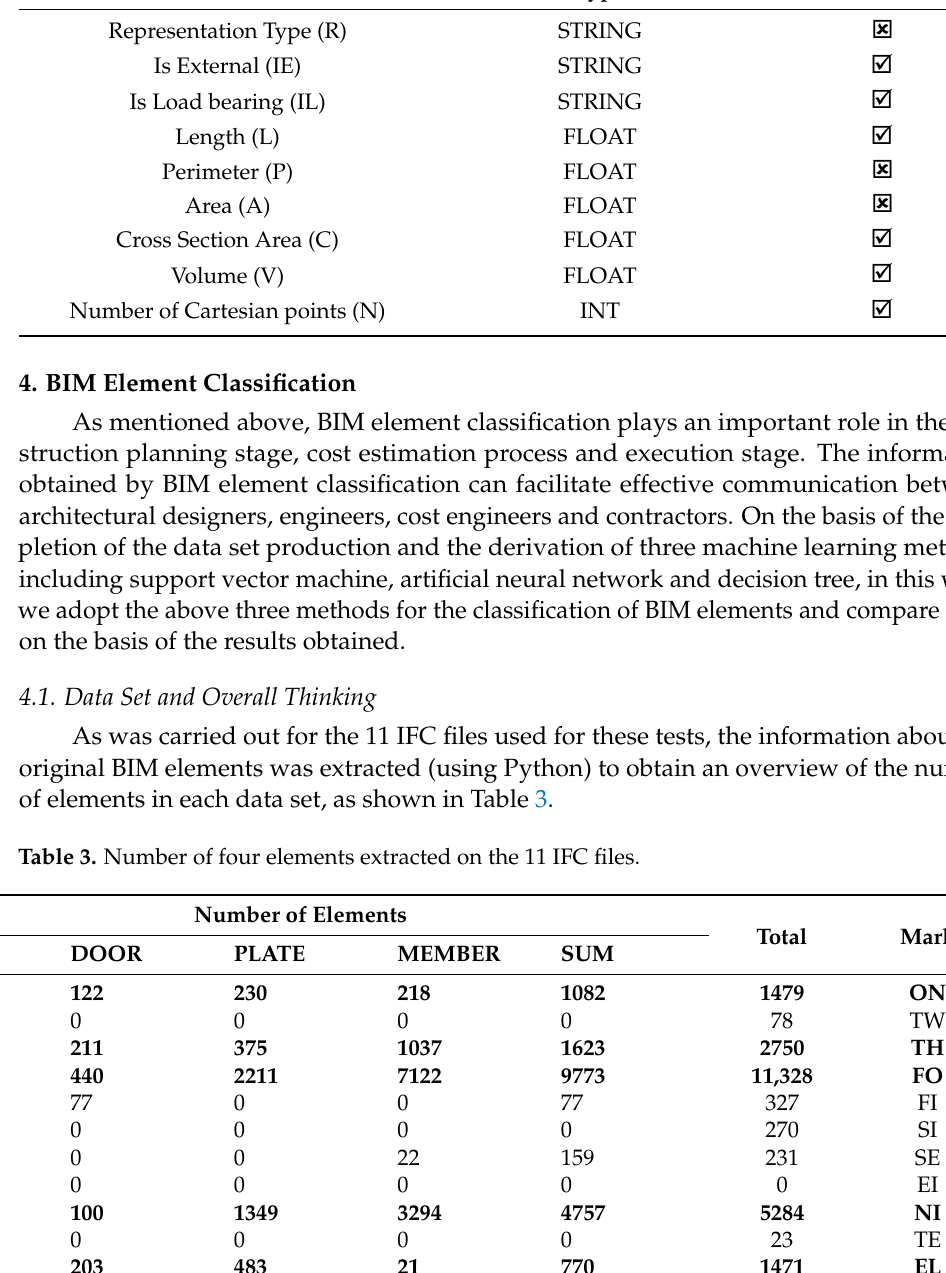
Table 2. Feature types and selection.